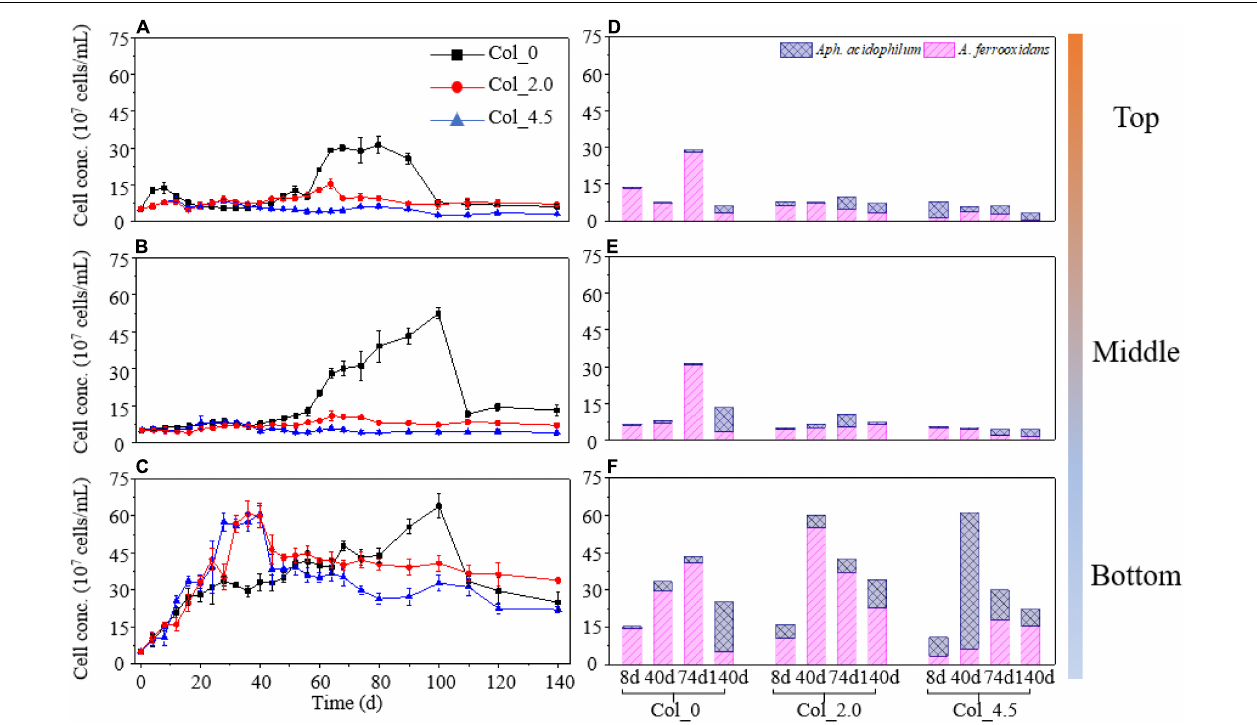
FIGURE 1 | Cell density (A–C) and bacterial composition (D–F) for the top (A,D) , middle (B,E) , and bottom (C,F) of the water columns without (Col_0) and with additions of 2.0 mM (Col_2.0) and 4.5 mM (Col_4.5) As(III). The initial cell density of At. ferrooxidans and Aph. acidophilum was the same, i.e., 2.5 × 10 7 cells/ml.